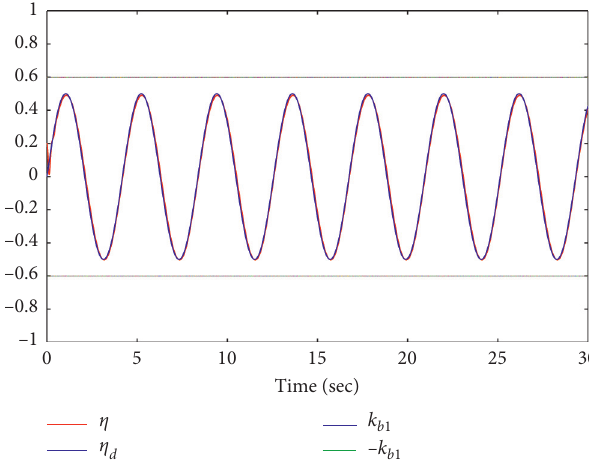
Figure 2: The output η and reference signal η